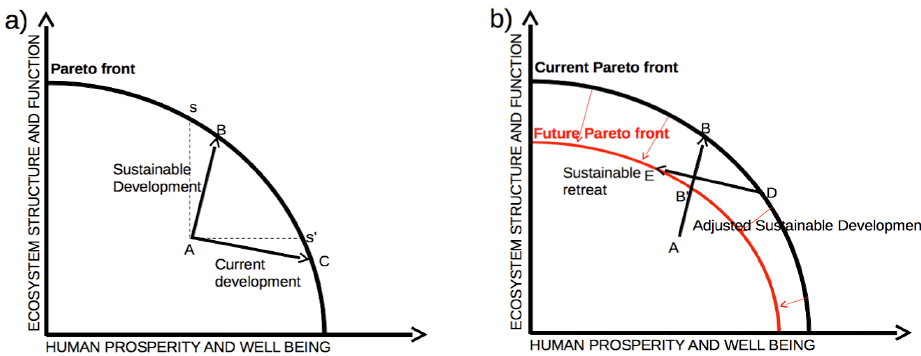
Figure 4. Sustainable development as an optimization exercise between human goal functions and ecosystem goal functions. a) The Pareto front is the set of efficient solutions (it means solutions where further human development would unavoidably lead to ecosystem damage, and vice versa). Trajectories from a present non Pareto-efficient situation A to B and C show the main development options. Trajectory AB evokes the challenge of sustainable development, increasing human goals without decreasing ecosystem goals. All trajectories between As and As' are Pareto efficient and therefore sustainable. Trajectory AC shows the current development trend, which is outside the trajectory range between As and As’ and therefore unsustainable, given that it increases human goals while decreasing ecosystem goals. b) As a consequence of anthropogenic environmental degradation the current Pareto front may shrink to a future Pareto front with lower potential exergy buffering for both sub-systems. Under such a regime shift (cf. Section 5.2) an effort of sustainable development AB will end up as an inferior adjusted sustainable development AB' (cf. [41]). Lovelock [42] considers that we are now already in a situation where further development without environmental damage is no-longer possible (this means that we are on or above the Pareto front) and where the shrinking resource base urges for a so-called sustainable retreat to a lower future Pareto front, which can be visualized by the trajectory